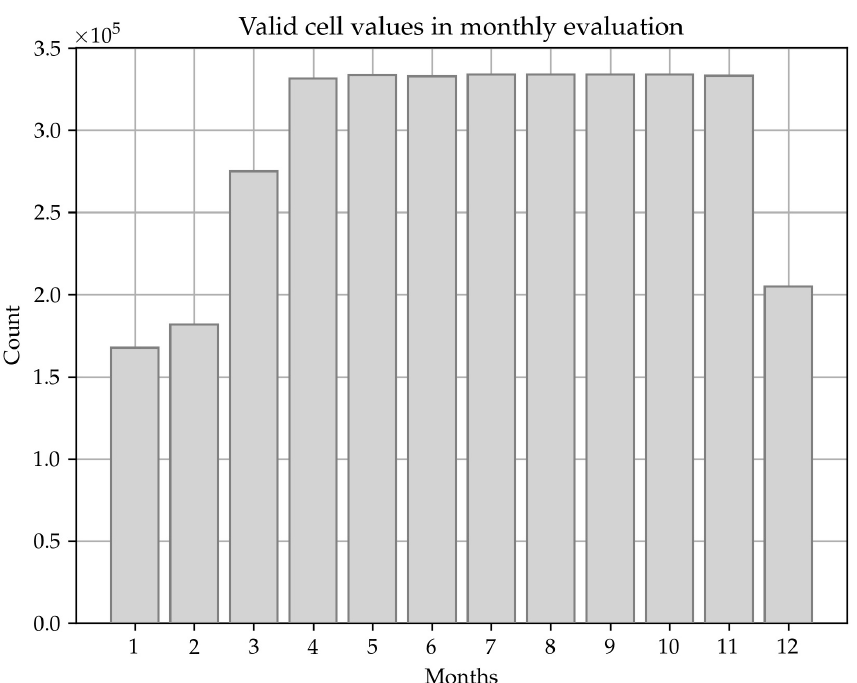
Figure A2. Count of valid unmasked grid cells available for monthly comparison of API and ESA CCI SM data.